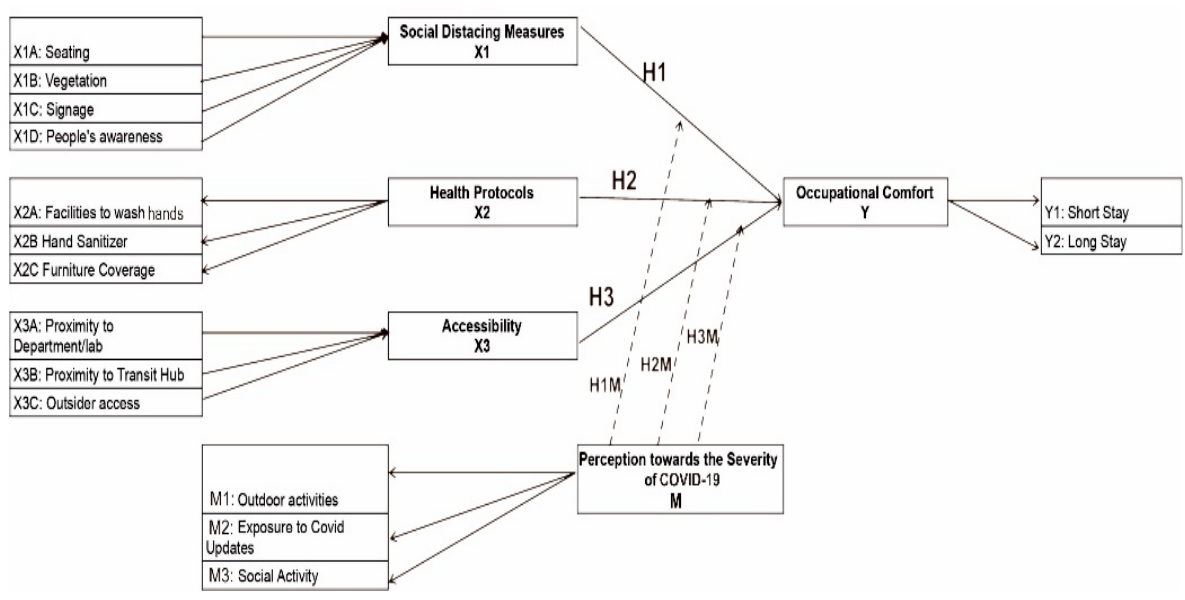
Figure 3. The statistical path model for the study.